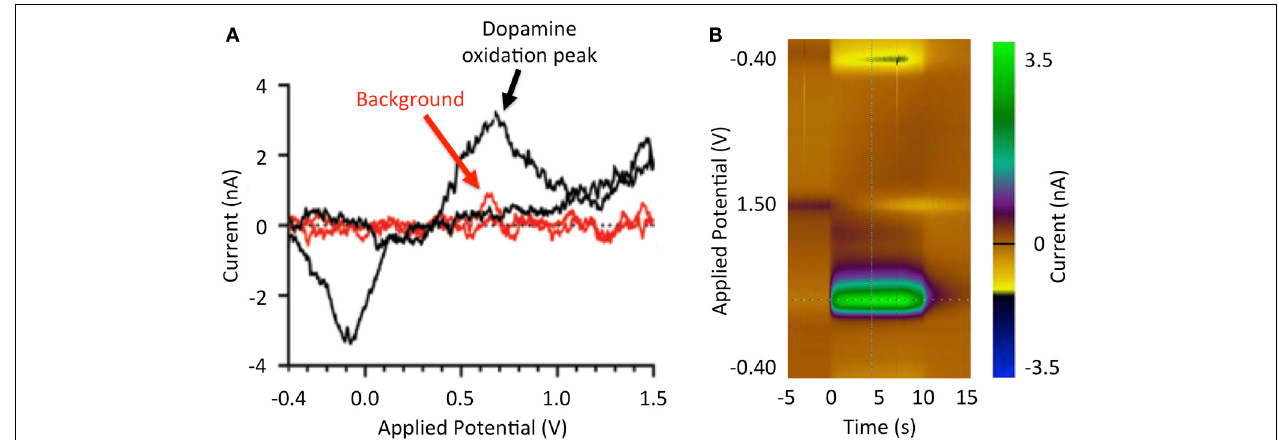
FIGURE 1 | Stimulation-evoked dopamine responses. (A) Dopamine redox reactions at the tip of a carbon fiber microelectrode during fast scan cyclic voltammetry. As the potential applied to the electrode increases from − 0.4 to 0.0V, extracellular dopamine is reduced (reduction peak at − 3.5nA). As the